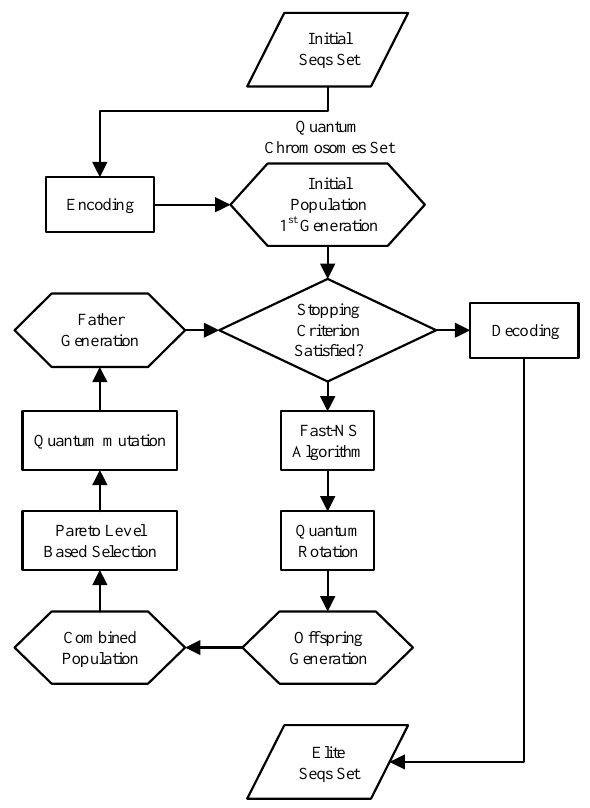
Figure 2. Framework of MoQGA for MIMO radar phase-coded waveform set design.